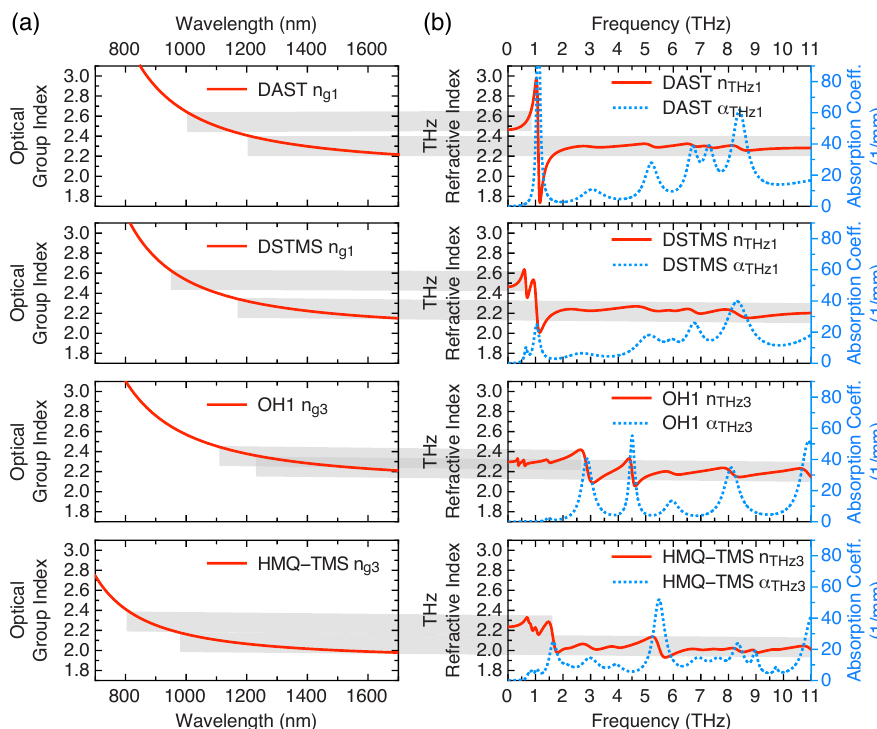
Figure 8. ( a ) optical group index n g ( λ ) as a function of wavelength for selected organic crystals; ( b ) optical properties in the THz range: the refractive index n THz ( f ) (red solid curves) and the absorption coefficient α THz ( f ) (blue dotted curves, right scale) as a function of frequency f = ω / ( 2 π ) . The corresponding properties are given for selected organic crystals along their polar axis, which is most often employed in THz applications. The n g ( λ ) are obtained from the dispersions n ( λ )